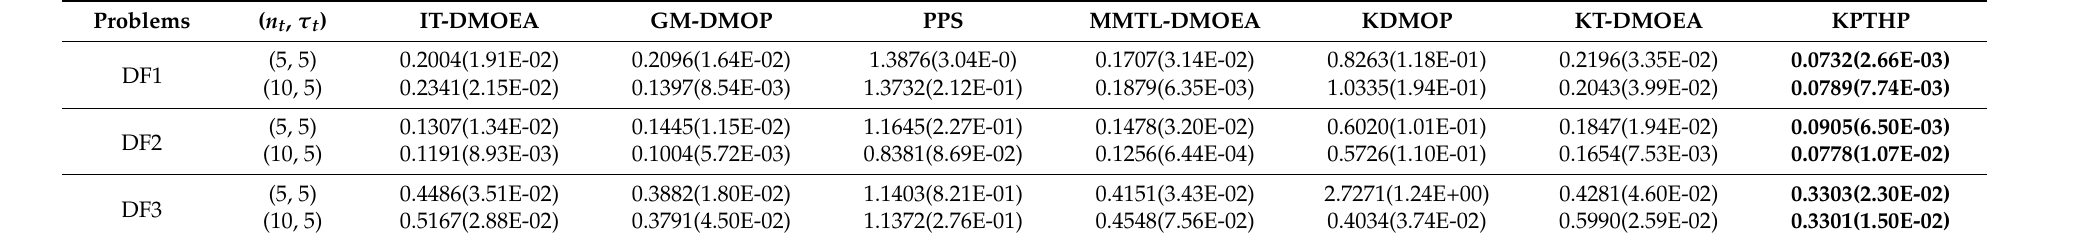
Table 8. Mean and SD of MIGD indicator obtained by seven algorithms for ( n t , τ t ) = (5, 10) and (10,